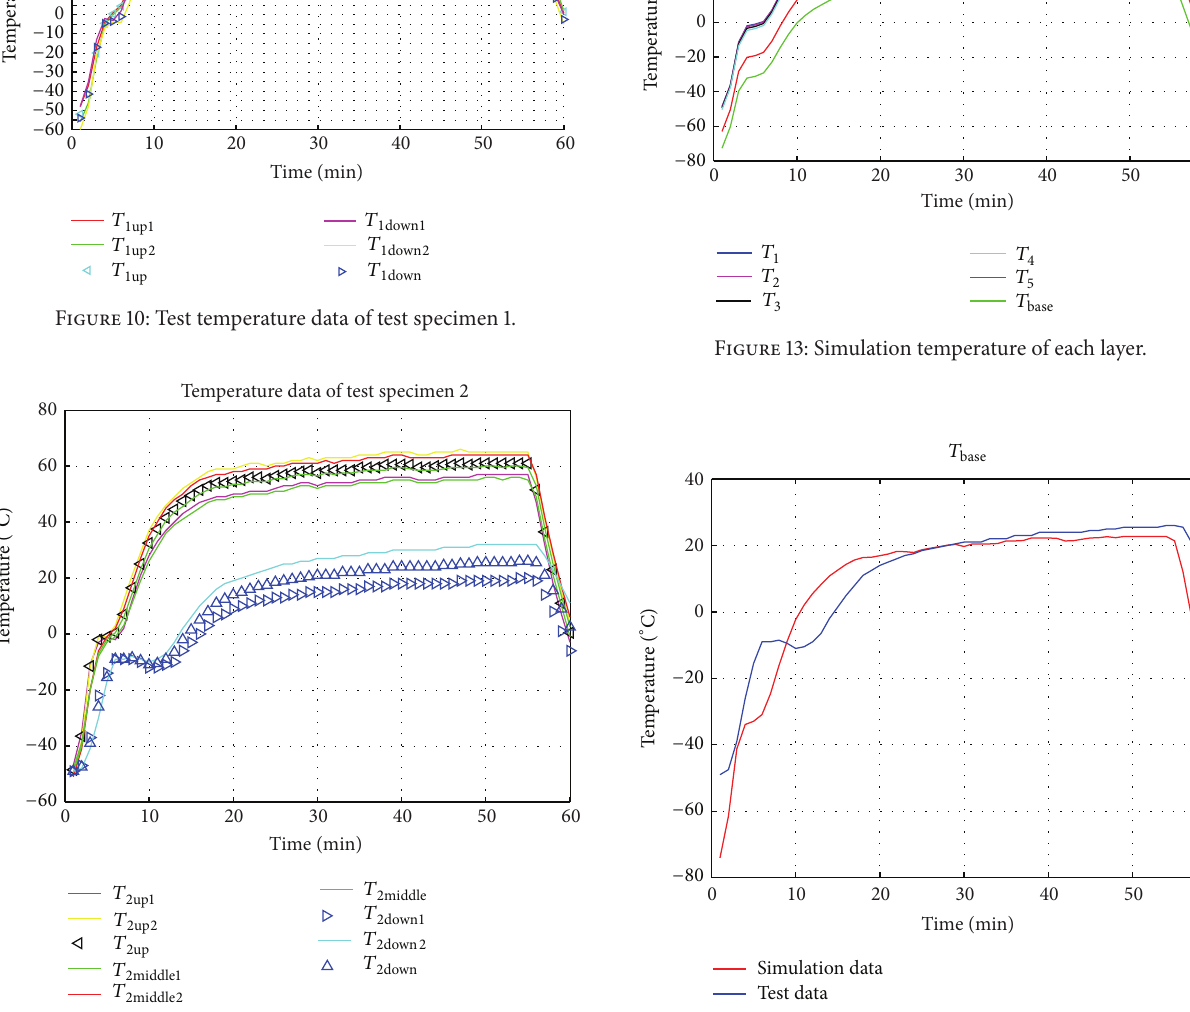
Figure 14: Simulation result and relevant test data of 𝑇